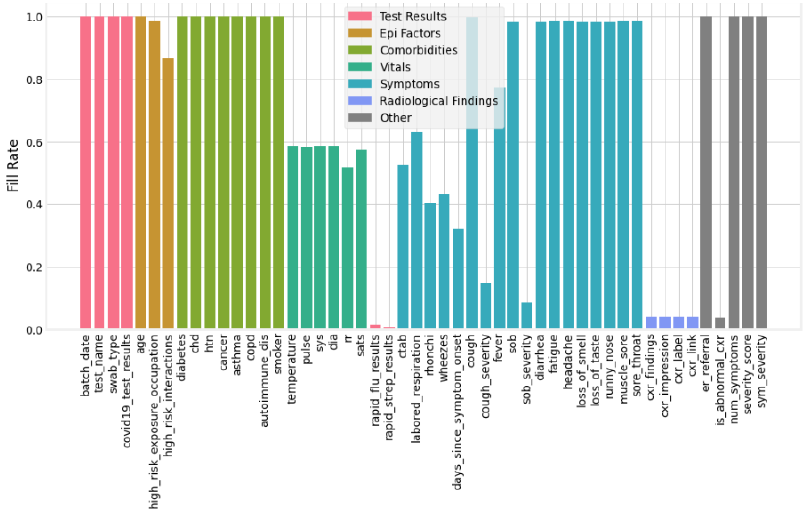
Figure 5. Filling rate of the